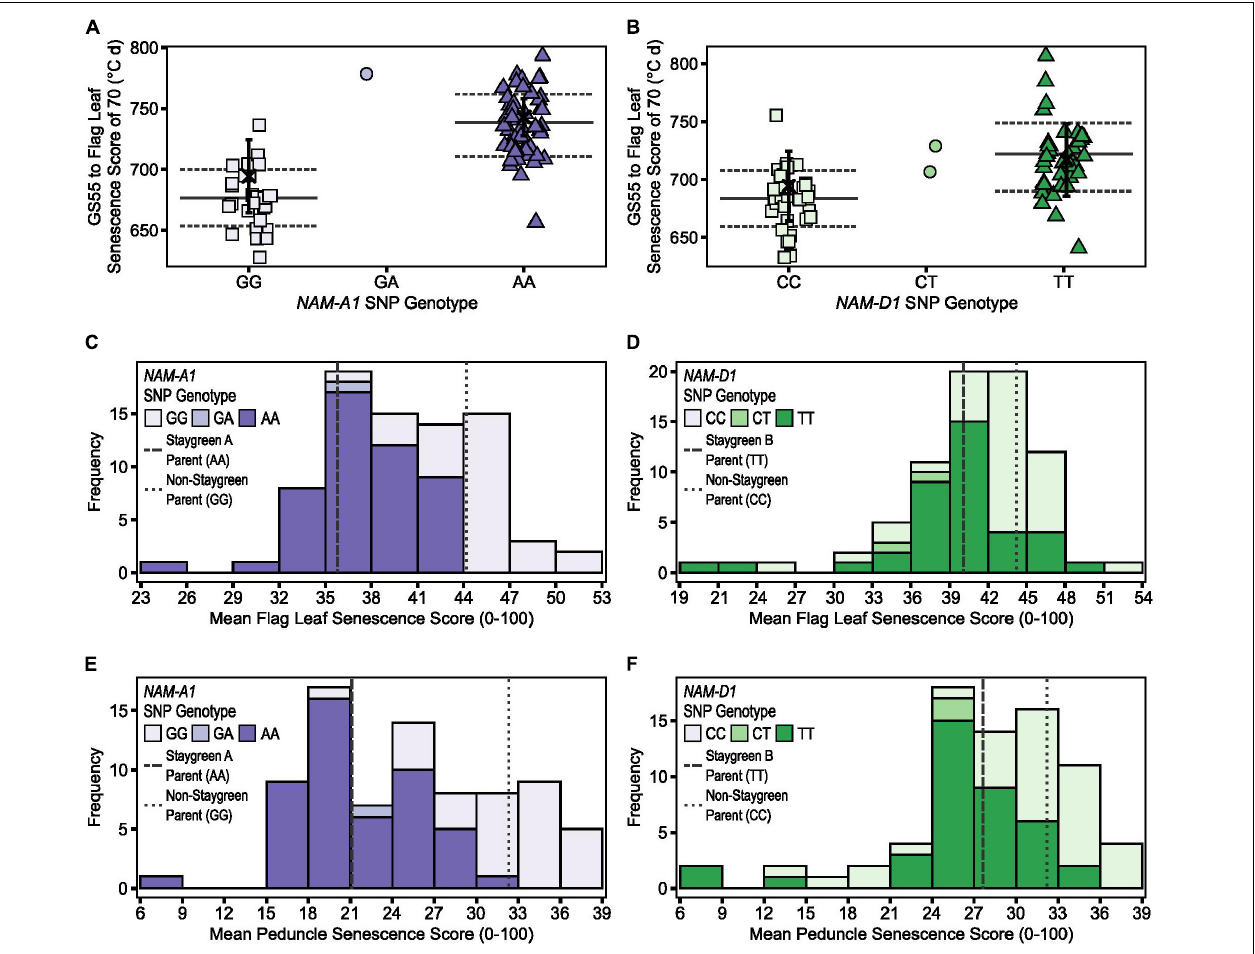
FIGURE 6 | Illustrating the differential power of metrics TT70, MeanLeaf, and MeanPed in discriminating senescence variation. Phenotypic differences were significant between homozygous RILs contrasting for mutations in NAM-A1 (Staygreen A) (A,C,E) and NAM-D1 (staygreen B) (B,D,F) according to TT70 (A,B) , MeanLeaf (C,D) , and MeanPed (E,F) scores, P ≤ 0.003. Metric MeanPed proved more informative when classifying senescence types compared to MeanLeaf due to the greater range and spread of scores. Phenotypic differences between parents were not significant, P > 0.05. (A,B) Scatterplot of TT70 scores against NAM-1 genotype; genotypic group mean (solid line) ± SD (dotted line), parental mean (black cross) ± SD. (C–F) Bars display mean MeanLeaf and MeanPed score recorded for two RIL populations, n ≥ 75 (two replicates) segregating for mutations in NAM-A1 (C,E) or NAM-D1 (D,F) ; allelic combinations, GG/CC = homozygous non-staygreen, AA/TT = homozygous Staygreen A/Staygreen B, GA/CT = heterozygous. Lines represent parental means ( n > 5); staygreen parents (dashed), non-staygreen parent (dotted). Trial grown at Church Farm, Bawburgh, Norwich (JIC),